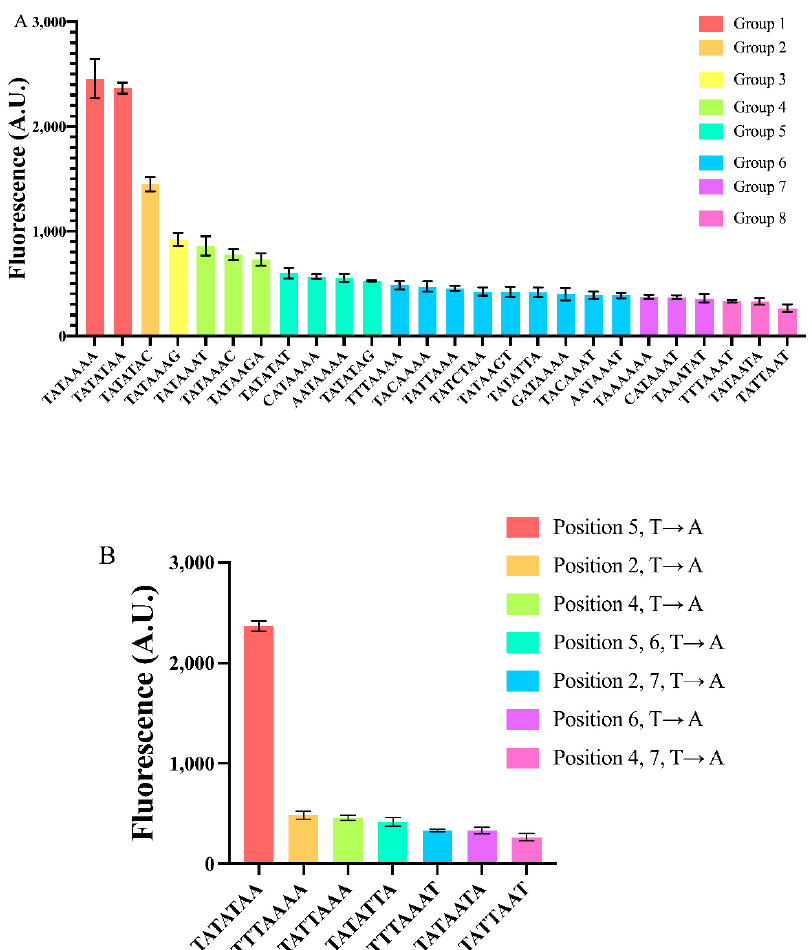
Figure 3. Constructing yeast synthetic core promoters via mutations on the TATA box. ( A ) Twenty-six core promoters have been realized via mutation(s) on the TATA box of pSV40core*(TATAAAA-90). They were distributed into eight groups depending on their strength. Groups were determined by both the two-sided Welch t–test and one-way ANOVA. ( B ) Effects of T → A mutation at different TATA box positions. Each mean fluorescence value comes from three independent experiments.